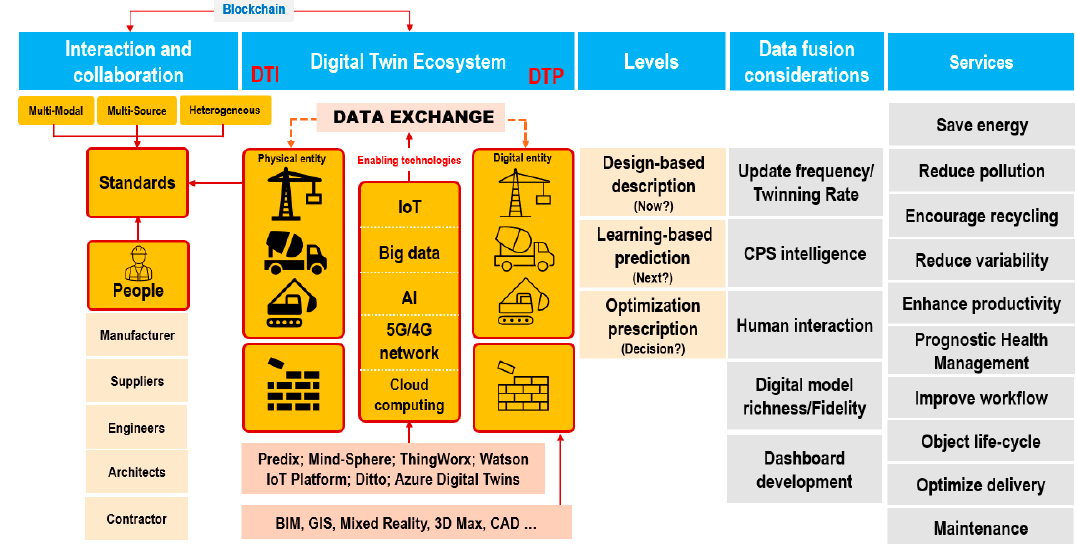
Figure 10. DT ecosystem including a taxonomy of DT tools, levels, and data fusion considerations. DTI: digital twin instance; DTP: digital twin prototype; CPS: cyber-physical system.